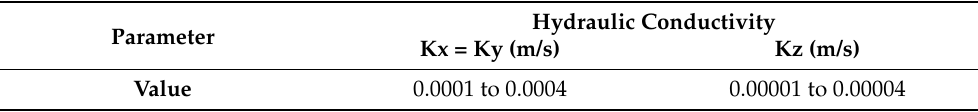
Table 1. Hydraulic conductivity